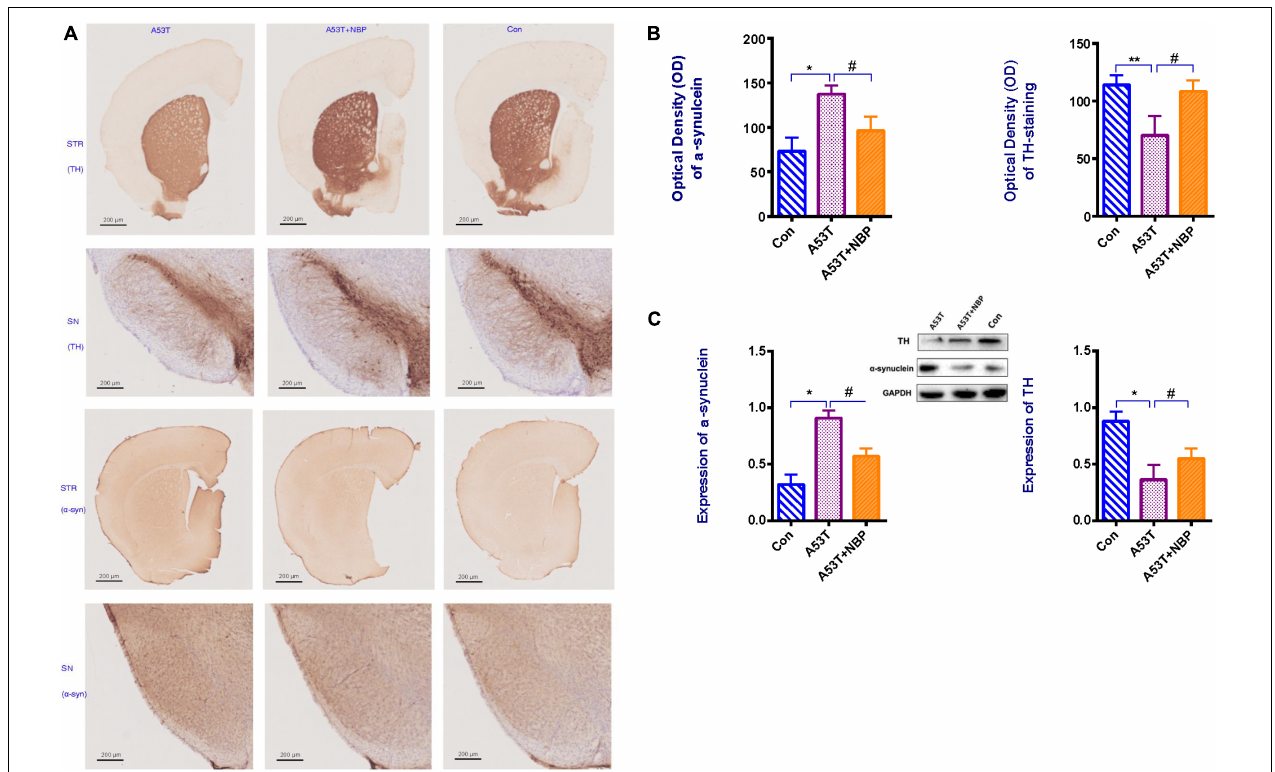
FIGURE 2 | Tyrosine hydroxylase (TH) content and α -synuclein level. (A) Visualization of TH content and α -synuclein immunohistochemical staining in corpus striatum (STR) and substantia nigra (SN) of subject mice. Less TH content and higher level of α -synuclein were detectable in the A53T group. (B,C) When quantified, optical density (OD) and expression of α -synuclein were higher, and OD and expression of TH-positive cells were decreased in the A53T group (* P < 0.05; ** P < 0.01). Following 2-week Dl-3-n-butylphthalide (NBP) application, the level of α -synuclein was lower and TH-positive cells were increased significantly ( # P < 0.05). All data were expressed as mean ±